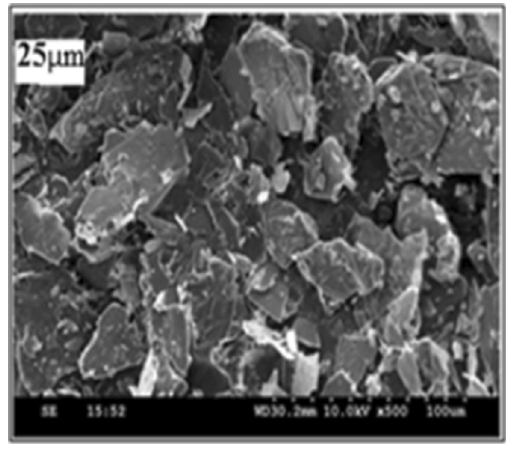
Fig.1 SEM image of graphite powder (Gr)